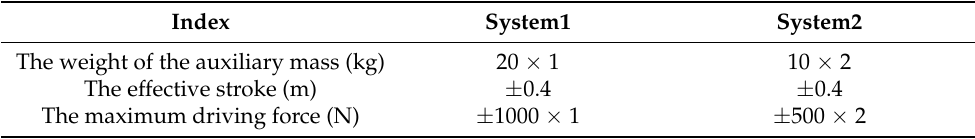
Table 1. The important parameters of different AMD systems.